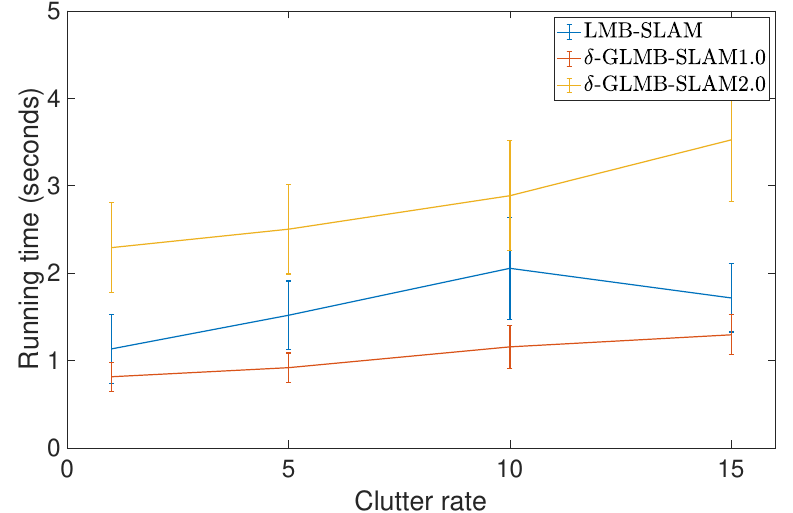
Figure 6. Comparison of average running time with standard deviation per time step under varying clutter